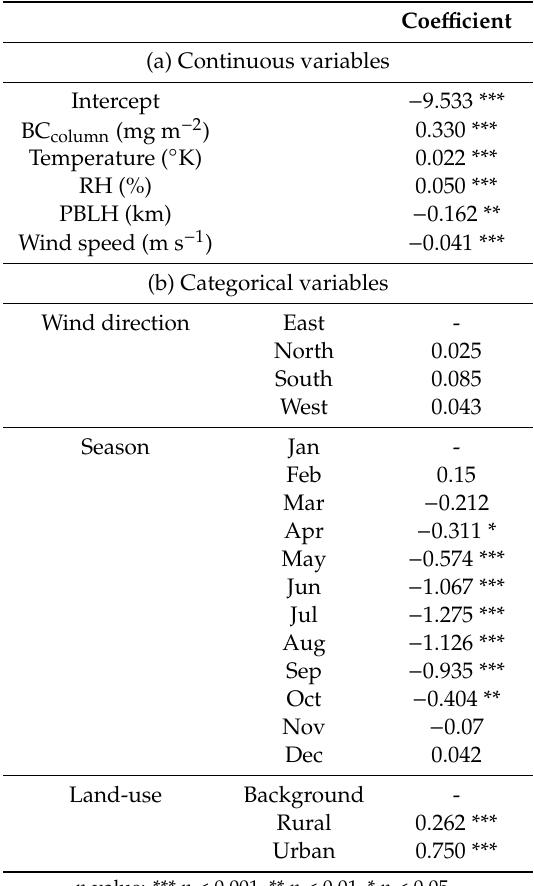
Table 5. Estimated regression coe ffi cients for the multiple linear regression (MLR)